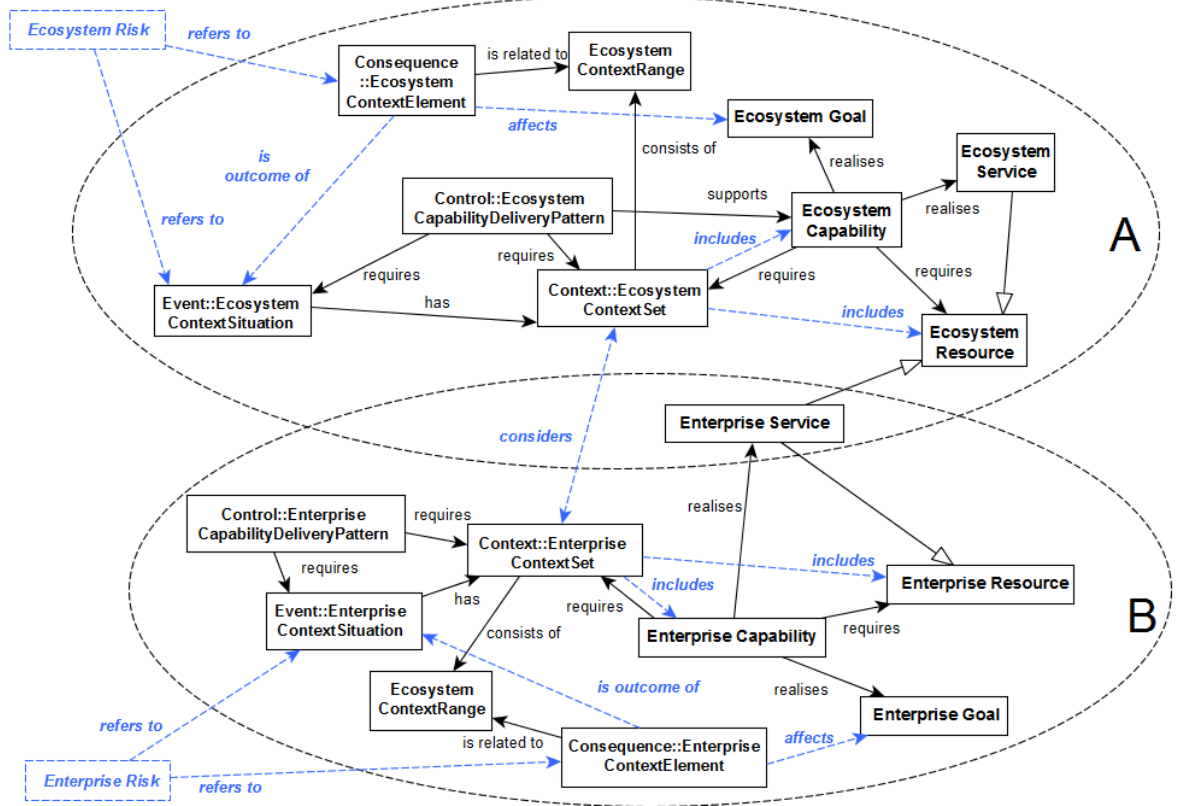
Figure 4. Mapping risk model – Extended BSE